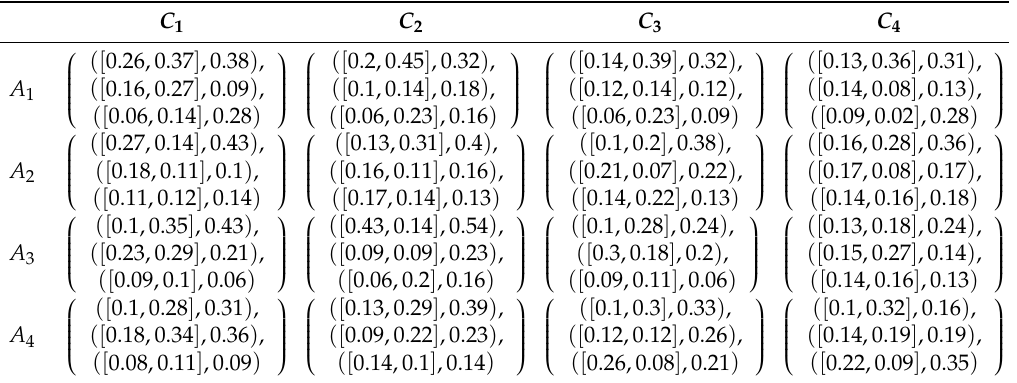
Table 5. Aggregation of all decision-maker data by the spherical cubic fuzzy Hamacher ordered weight average (SCFHOWA) operator. C 1